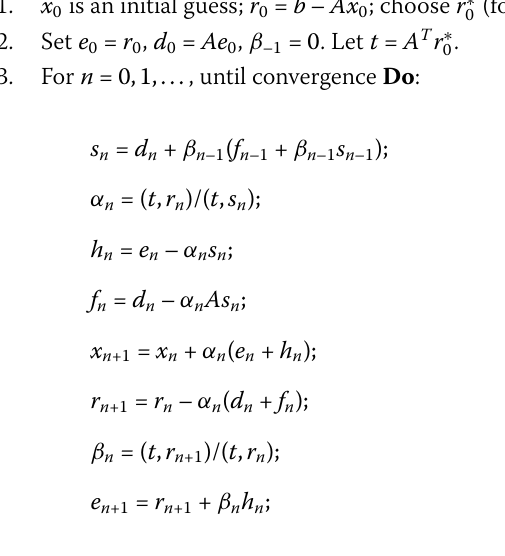
Algorithm 2.1 (The first form of CRS method (CRS1)